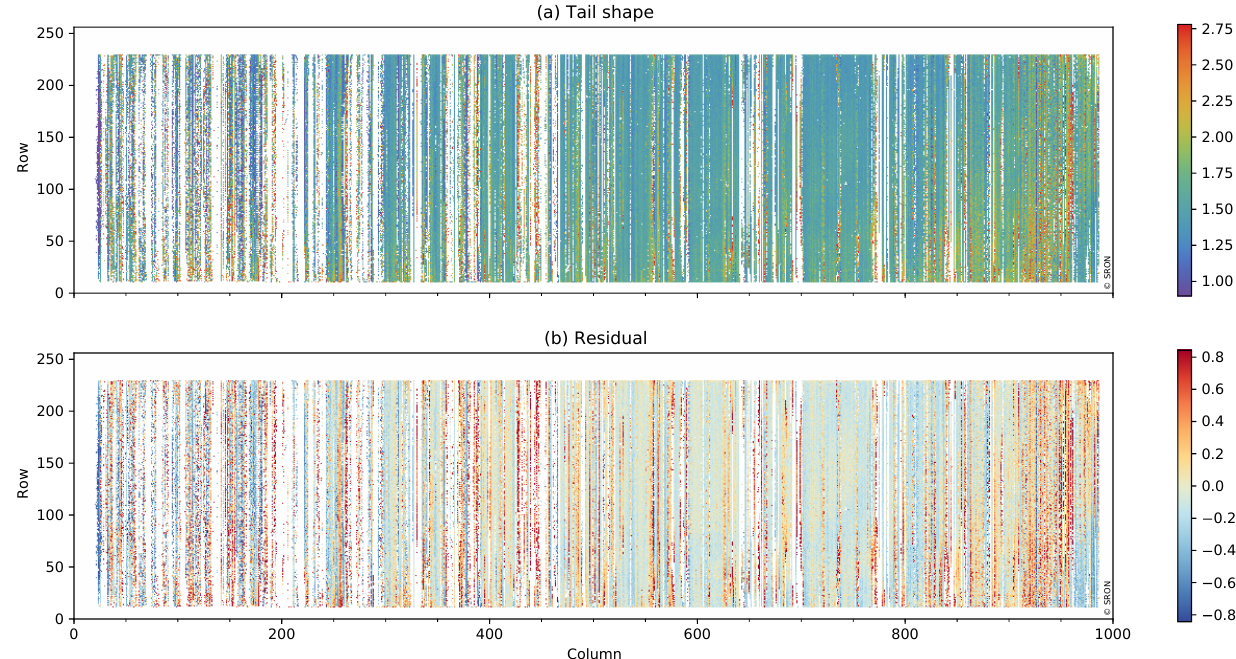
Figure 13. ISRF tail parameter m (irradiance port). Panel (b) shows the difference between m and its bivariate polynomial fit. No measure- ments are performed in the white edges. White vertical stripes are due to saturation in the measurements. Red vertical stripes are due to nearby saturation or laser instabilities.